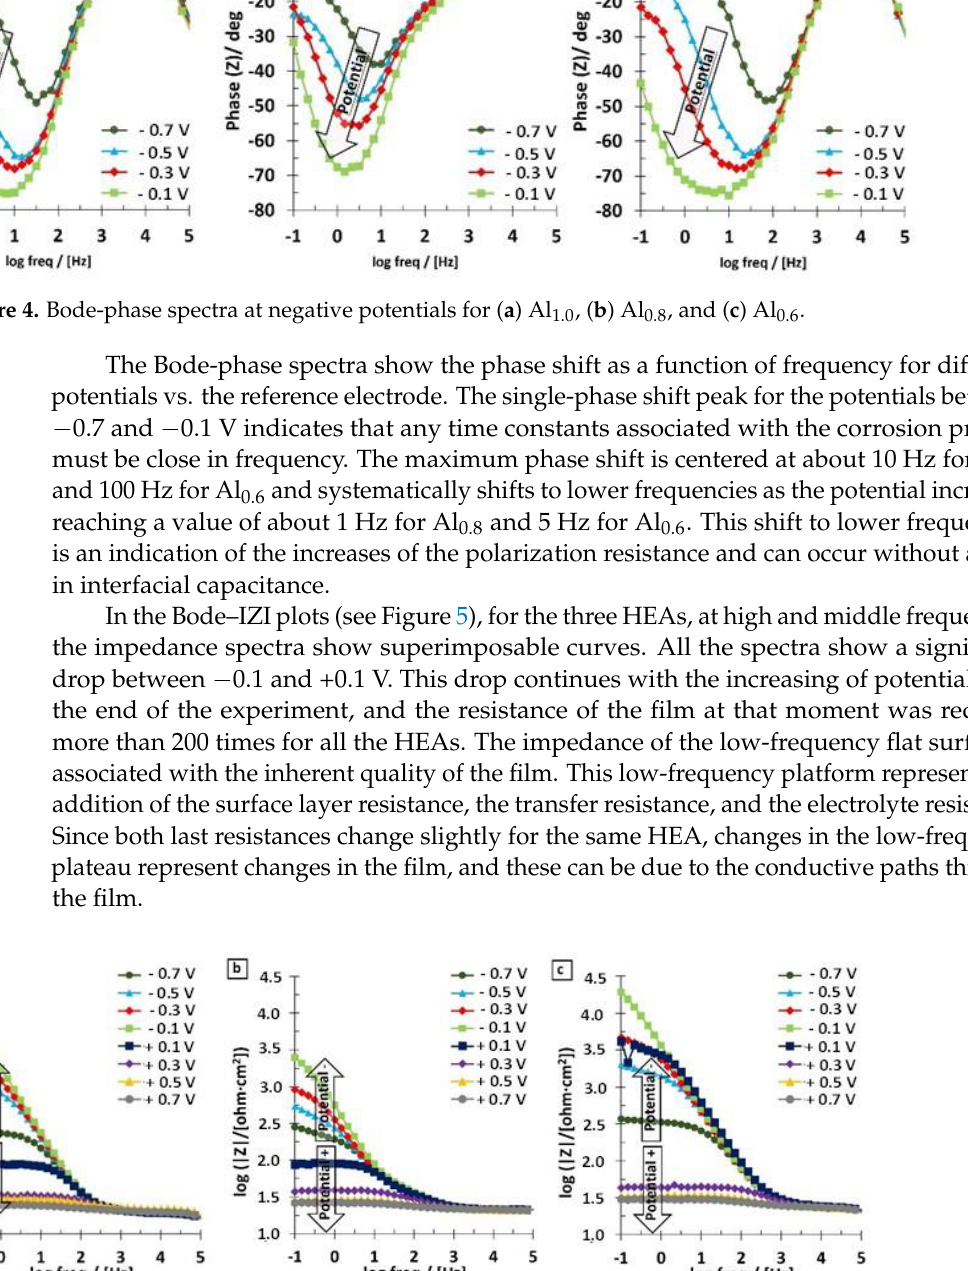
1.0 , ( b ) Al 0.8 , and ( c ) Al 0.6